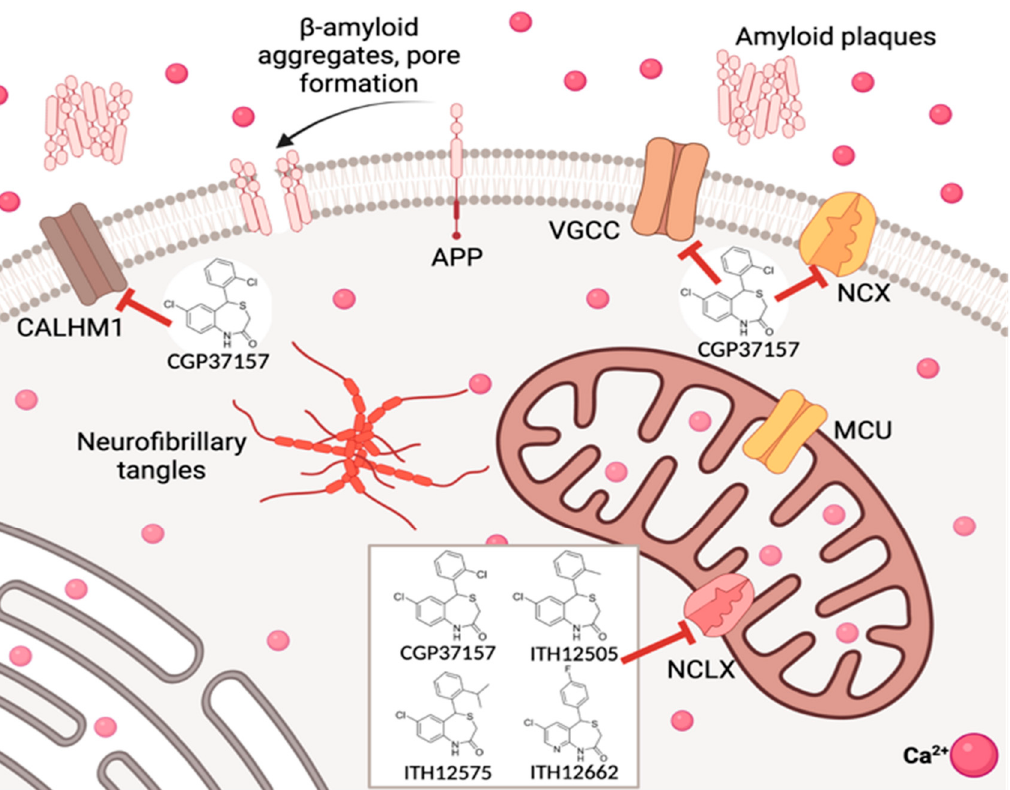
Figure 4. Biological targets of CGP37157 and derivatives that participate in cell Ca 2+